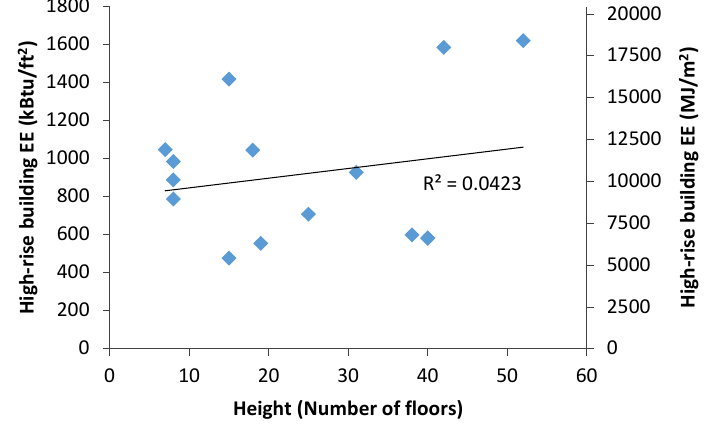
Figure 7. Correlation between embodied energy (EE) and building height for high-rise case studies in the